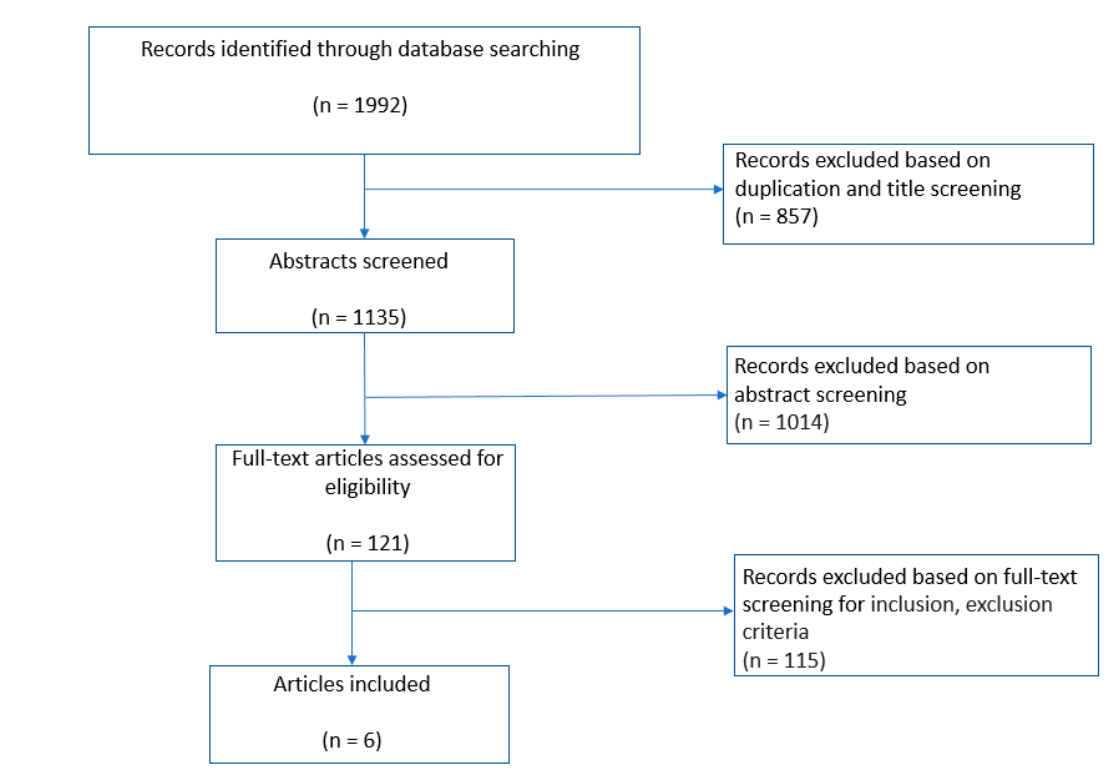
Figure 1. Strategy of literature review process.